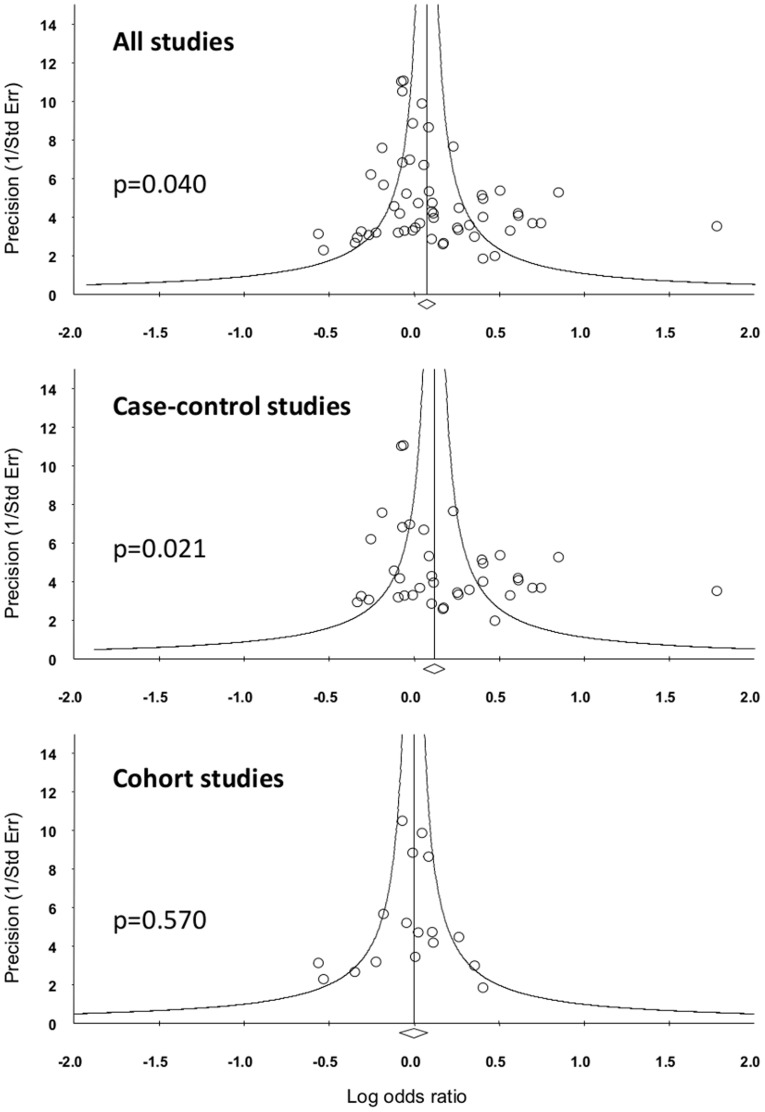
Funnel plots to assess publication bias.For each study, the log odds ratio is shown against study precision. The open diamond below the x-axis indicates the pooled odds ratio. p-values are reported for Egger's regression intercept, where p>0.05 suggests a low probability of publication bias.